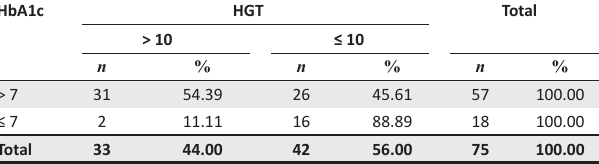
TABLE 2: HbA1c levels greater than 7 % and hemo-glucose test levels greater than 10 mmol/L. HbA1c